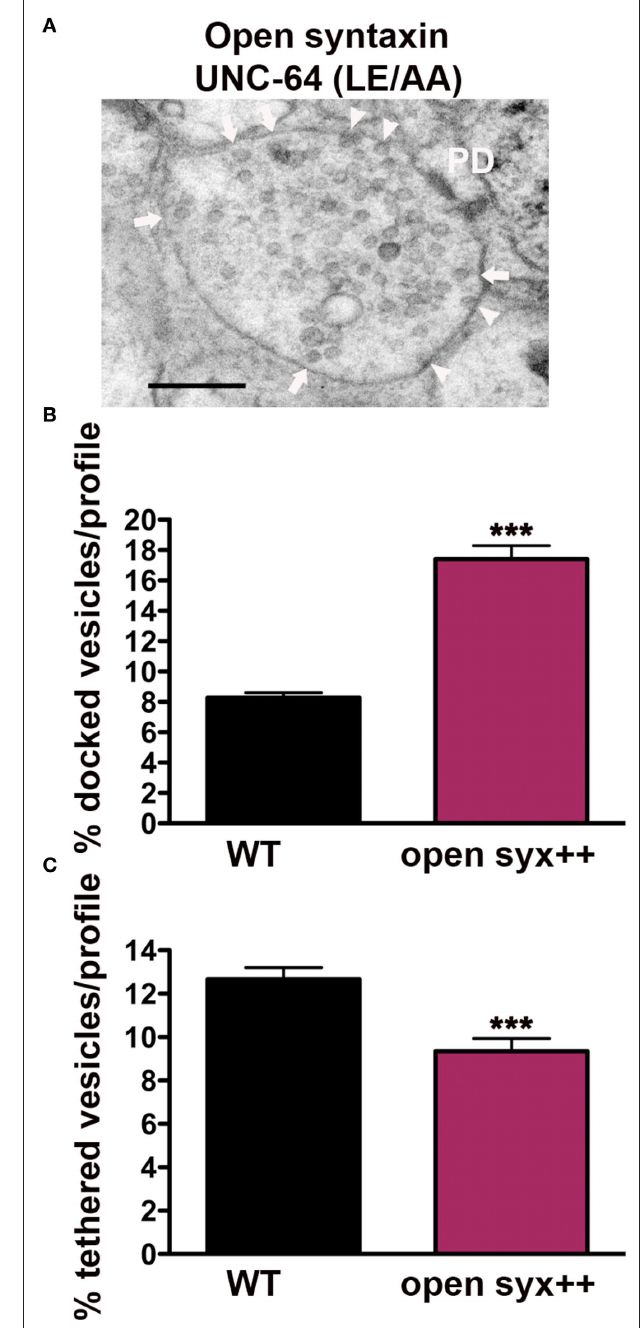
FigUre 4 | Synaptic vesicle tethering and docking are differentially regulated by syntaxin open state conformation. (A) Representative electron micrograph of an NMJ profile from syntaxin null mutants rescued with open syntaxin (LE166/167AA) (strain EG1985). Arrowheads indicate plasma membrane docked synaptic vesicles, arrows indicate tethered synaptic vesicles ( < 25 nm of the plasma membrane), PD presynaptic density, scale bar 200 nm. Average docked (B) and tethered (C) synaptic vesicles expressed as a percentage of total vesicles per synaptic profile. Open syntaxin ( n = 59 synaptic profiles, vesicle density 29.8 ± 1.2), wild-type ( n = 178 synaptic profiles, vesicle density 20.2 ± 0.6). *** p < 0.001 relative to